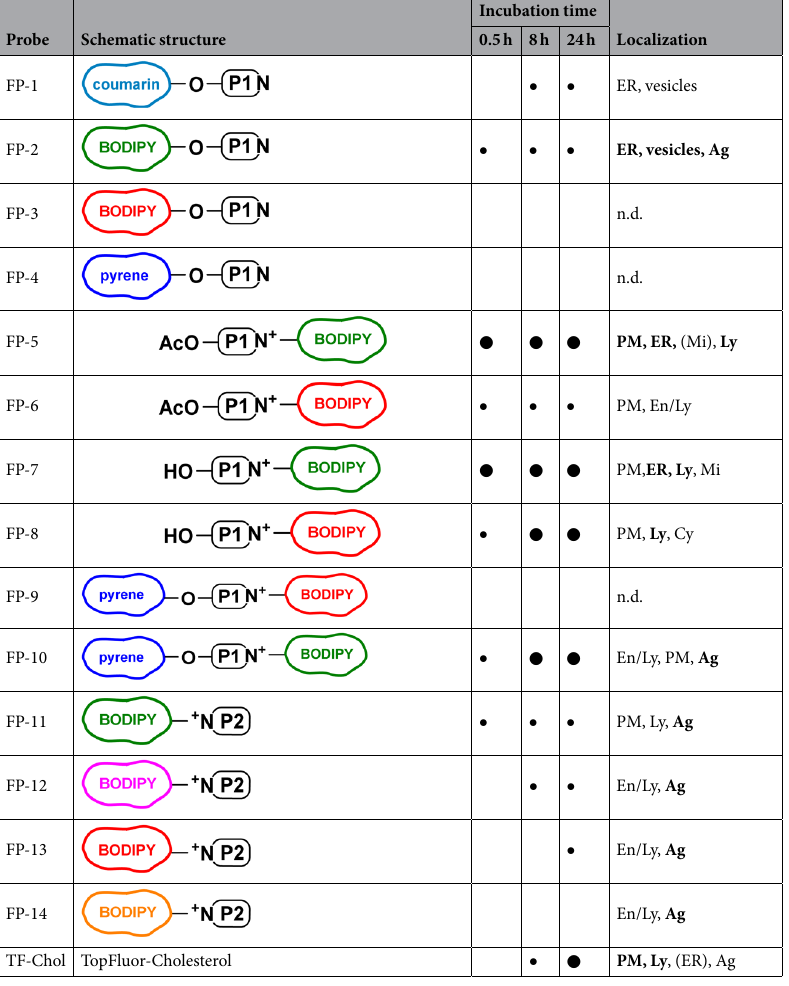
Table 1. Intensity of intracellular fluorescence of novel sterol sensing probe. Fluorescence was evaluated under identical microscopic settings: • weak, • medium, ● strong, n.d. - not detected. Localization: ER - endoplasmic reticulum, PM - plasmatic membrane, Ly - lysosomes, En/Ly - endosome/lysosome compartment, Cy - cytoplasm, Mi - mitochondria, Ag - probe aggregates. Bold indicates intensive labelling in particular compartment(s).